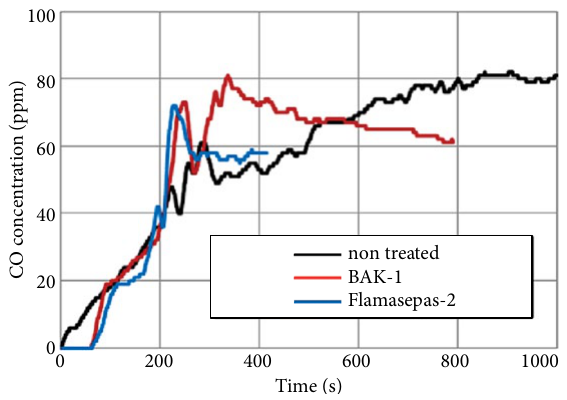
Fig. 20. CO concentration during the combustion of non- treated and impregnated pine timbers measured by the sensor in the centre of the compartment at a height of 1.6 m